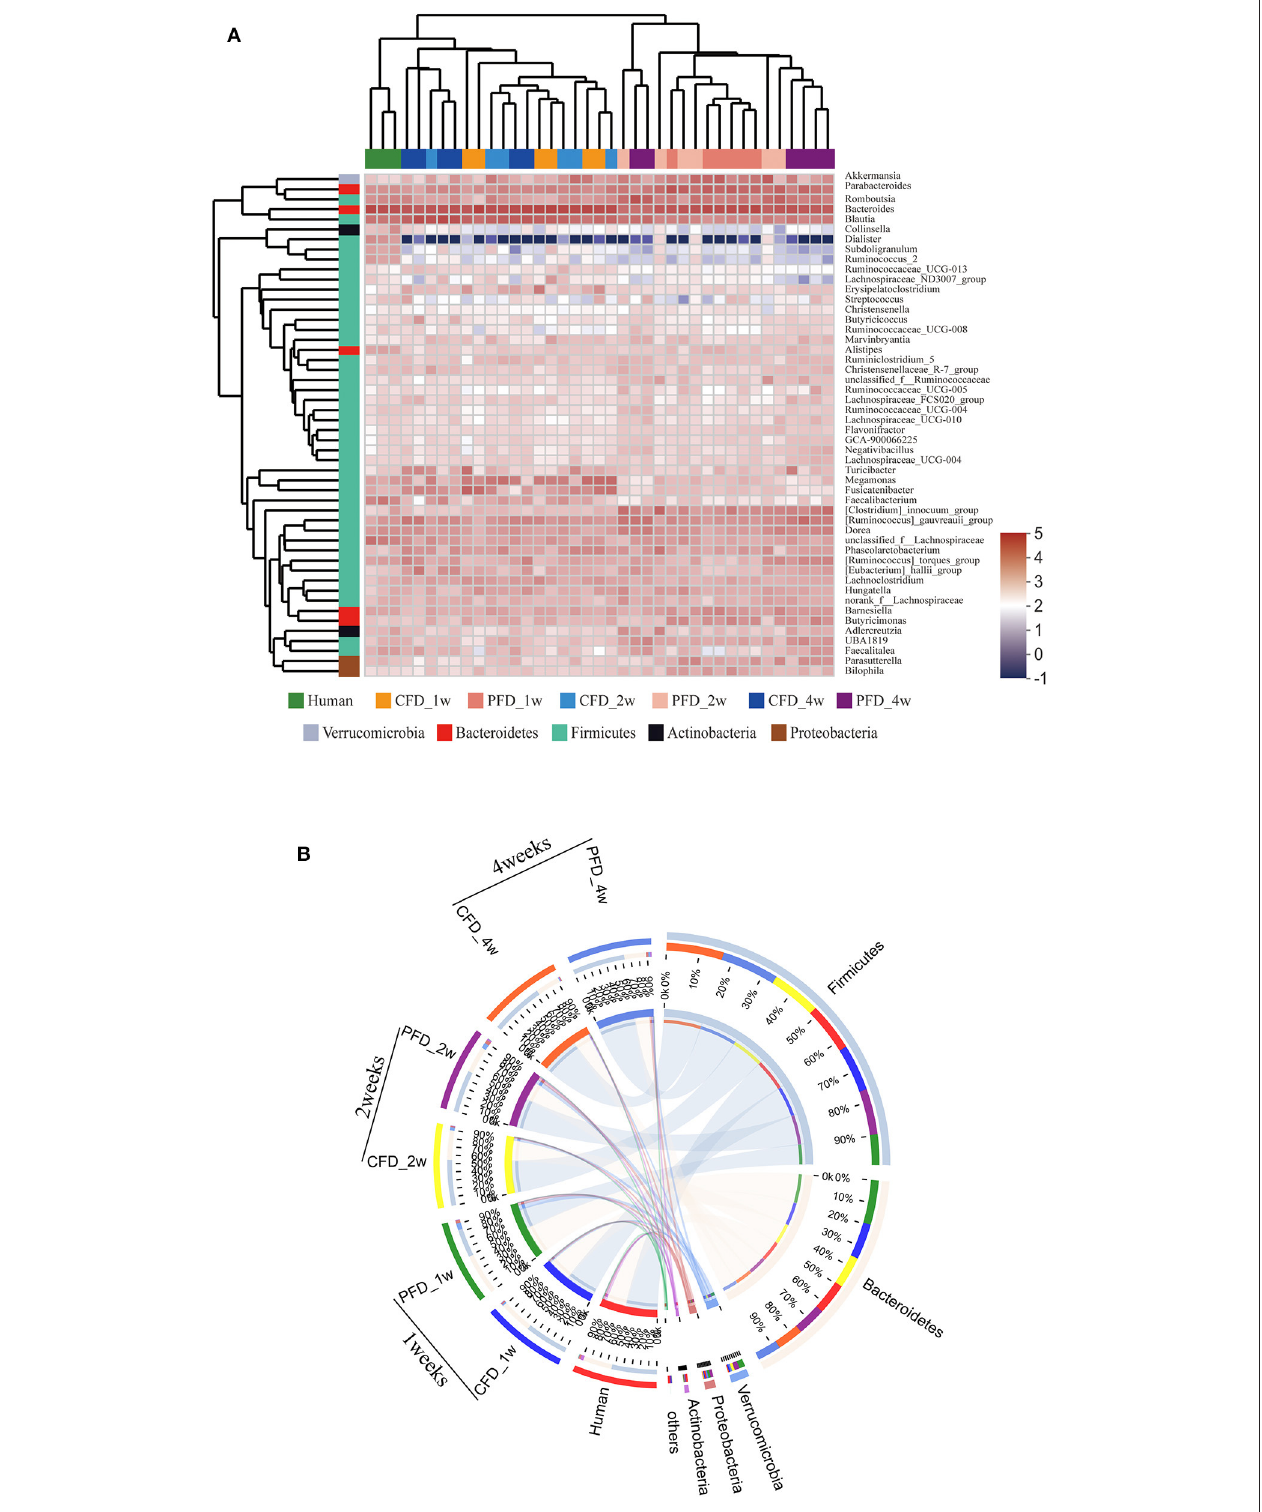
FIGURE 5 | (A) Dendrograms of hierarchical cluster analysis at genus level and sample clustering are shown at left and bottom, respectively. Color gradient represents the datum values of relative abundances by l g. (B) The data were visualized by Circos. The width of the bars from each phylum indicate the relative abundance of that phylum in the